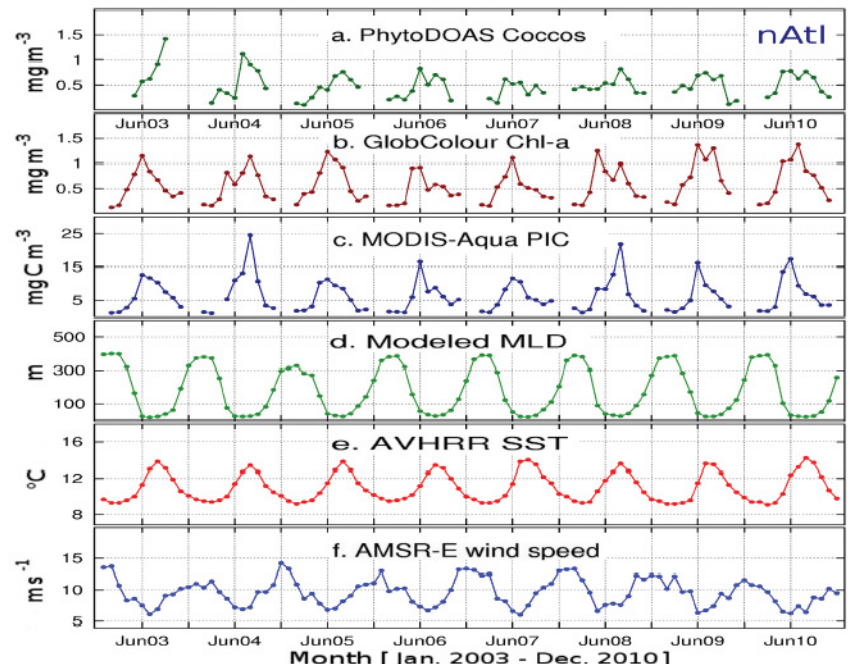
Fig. 3. Time series of six parameters monitored in nAtl from January 2003 to December 2010: (a) coccolithophore chl a conc. retrieved by PhytoDOAS; (b) GlobColour total chl a ; (c) MODIS-Aqua PIC conc.; (d) MLD from ocean productivity; (e) SST from AVHRR; and (f) surface wind-speed from AMSR-E.